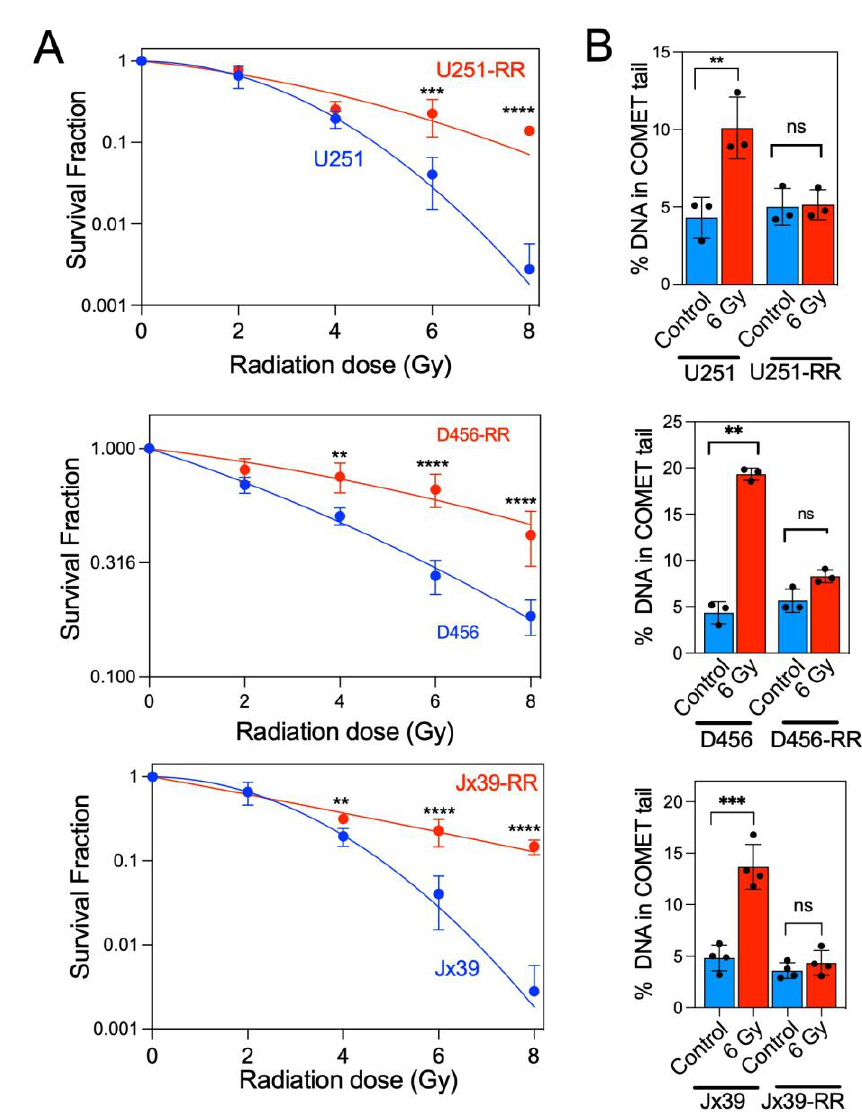
FIGURE 1: Fractionated radiation promotes acquired radioresistance in GBM cell lines. (A) Clonogenic survival curves for radiosensitive (U251, D456, and Jx39) and isogenic radioresistant (U251-RR, D456-RR and Jx39-RR) cell lines. Cells were irradiated with 2, 4, 6, or 8 Gy and immediately plated. Clonogenic survival was estimated on day 14 after irradiation. (B) Quantification of post-irradiation DNA damage in the radiosensitive and radiore- sistant GBM cells, assessed by sin- gle-cell gel electrophoresis assay under neutral conditions (neutral comet assay). Data are presented as the mean  SEM (n=3). p < 0.01 (**), p < 0.001 (***), and p < 0.0001 (****), calculated by Student t-test. ns, not